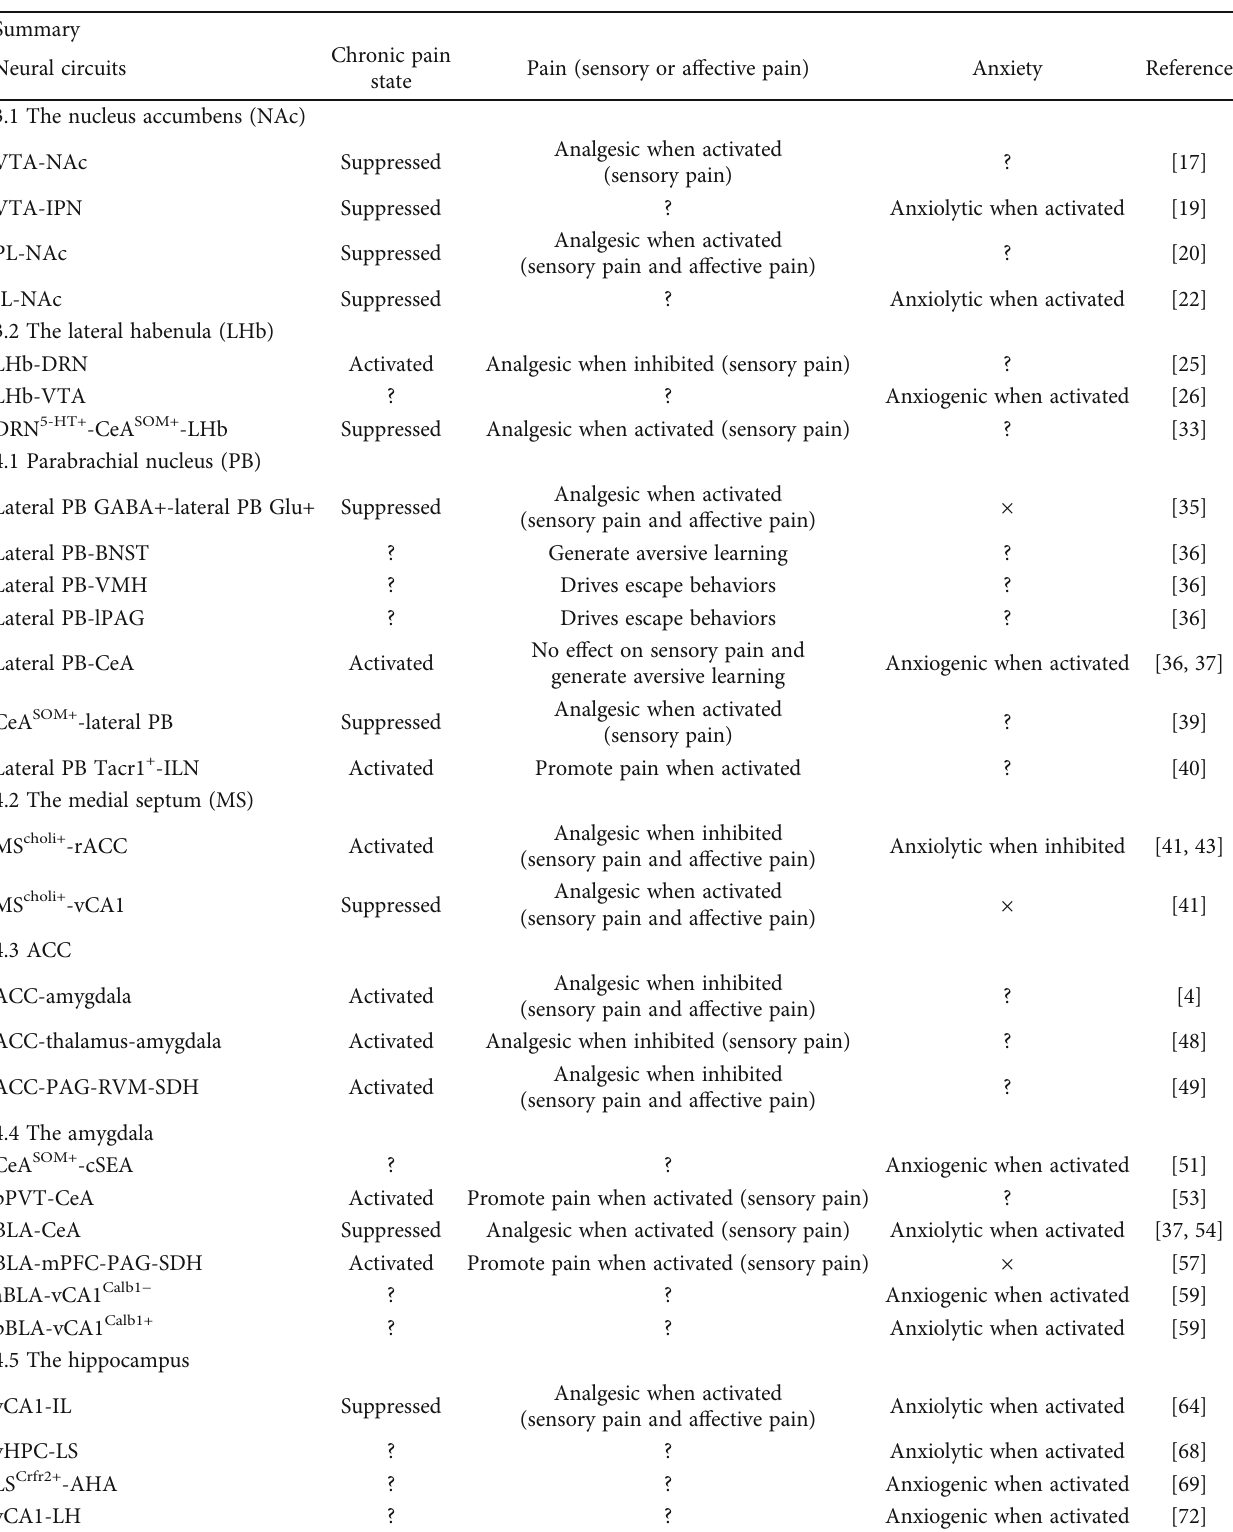
Table 1: Neural circuits that serve to promote or inhibit pain and anxiety. Summary of the current understanding of the neural circuits involved in or potentially involved in the comorbidity of chronic pain and anxiety. Pain-like behaviors can be measured in two aspects — sensory pain and a ff ective pain. We measure sensory pain via withdrawal thresholds or latencies, and we measure a ff ective pain via conditioned place avoidance or preference. ?, not con fi rmed; × , no e ff